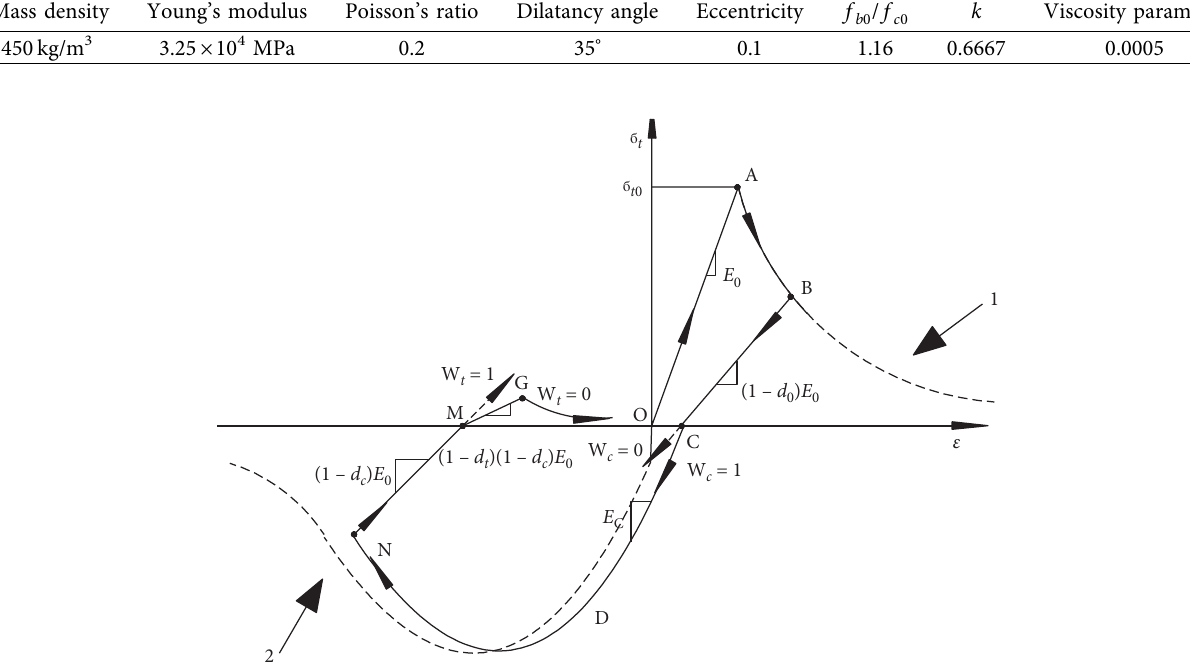
Figure 9: Concrete uniaxial tension and compression characteristic